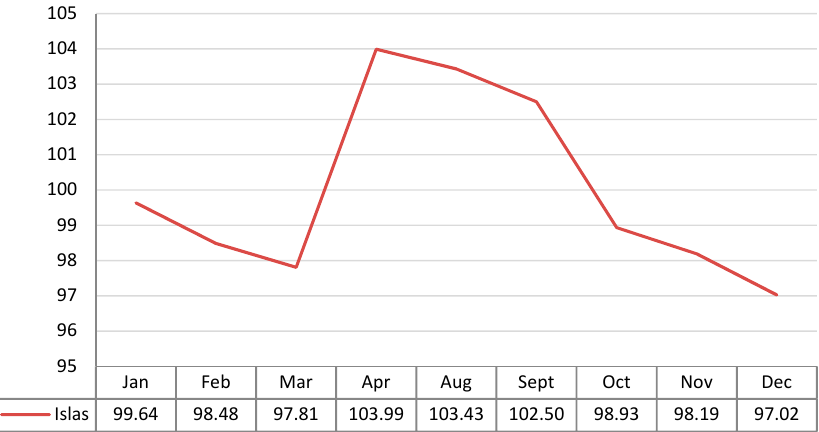
Figure 7. Total light emitted/radiant intensity (>2 nW/sr). Monthy means 2012–2017. Balearic Islands. In indexed numbers (annual mean = 100).